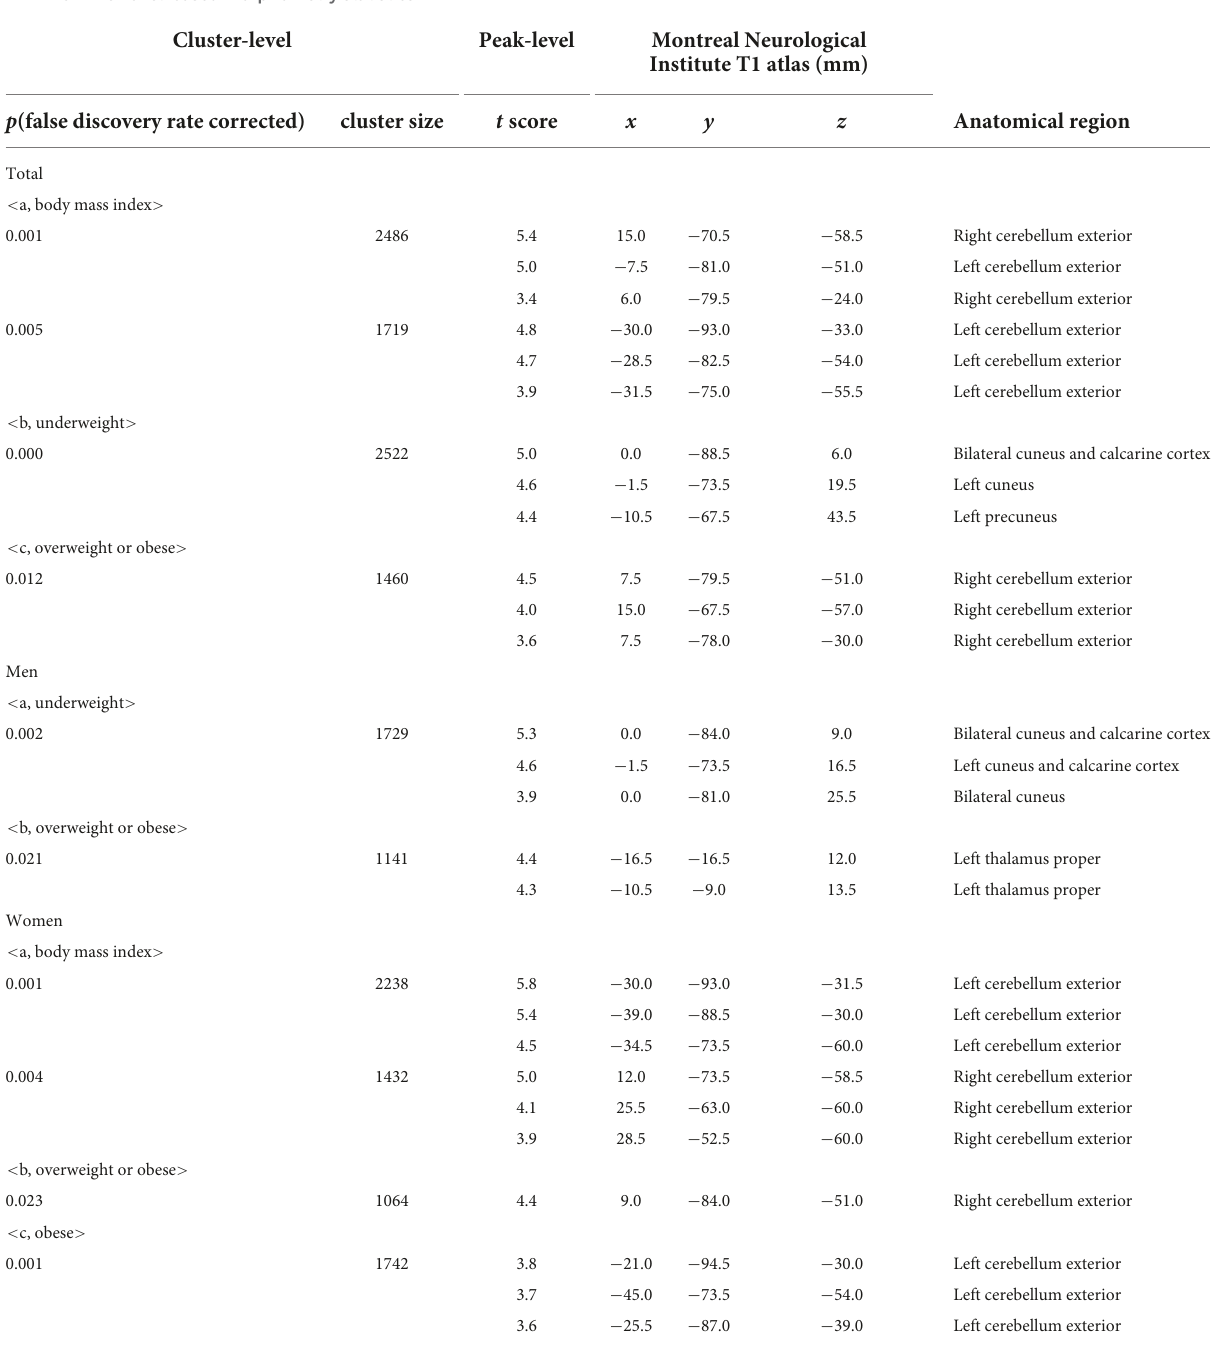
TABLE 5 The voxel-based morphometry